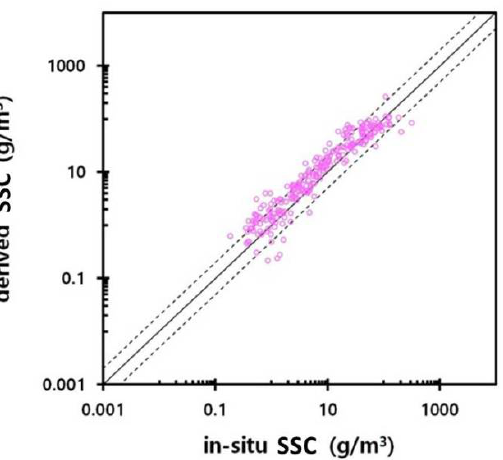
Figure 1. Derived-from-GOCI concentration of SSC vs. in-situ measurements [4]. The dashed lines correspond to a ratio of 2 and 1/2 of derived to measured values.